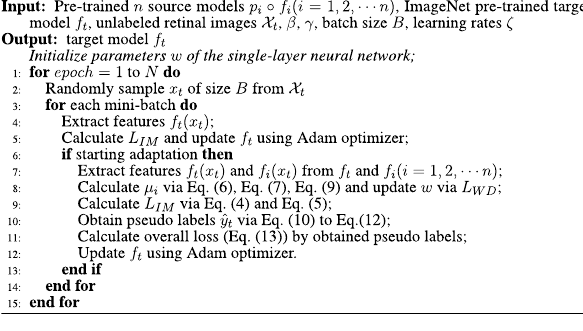
Algorithm 1. Pseudo-code of MMDA training